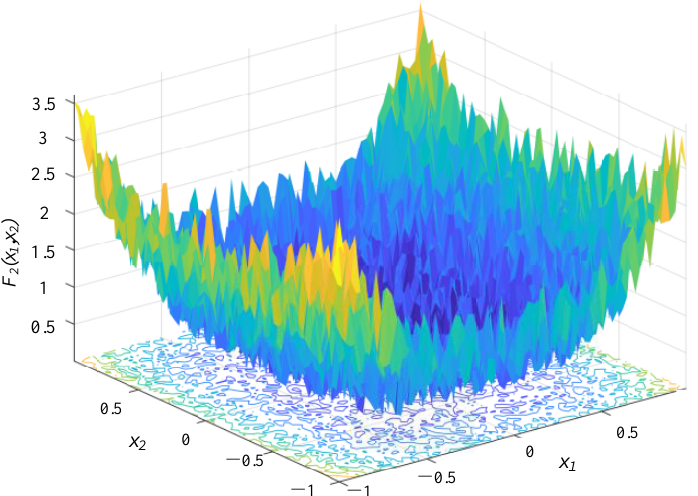
Figure 8. Testing function F 2 ( x ).